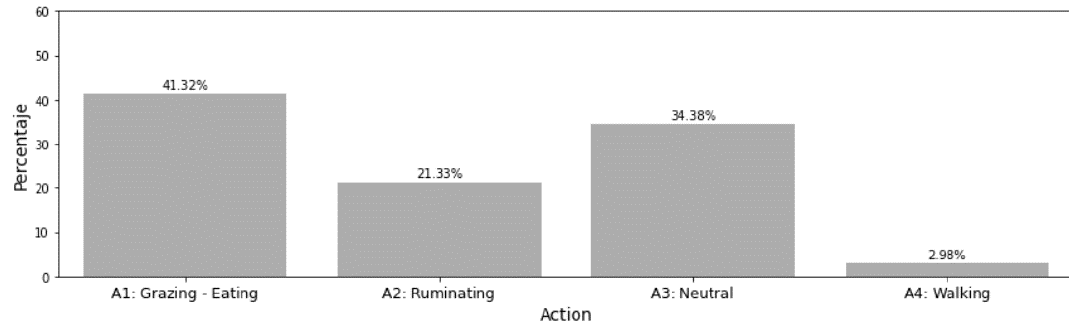
Figure 4. Distribution of general behaviour annotations.